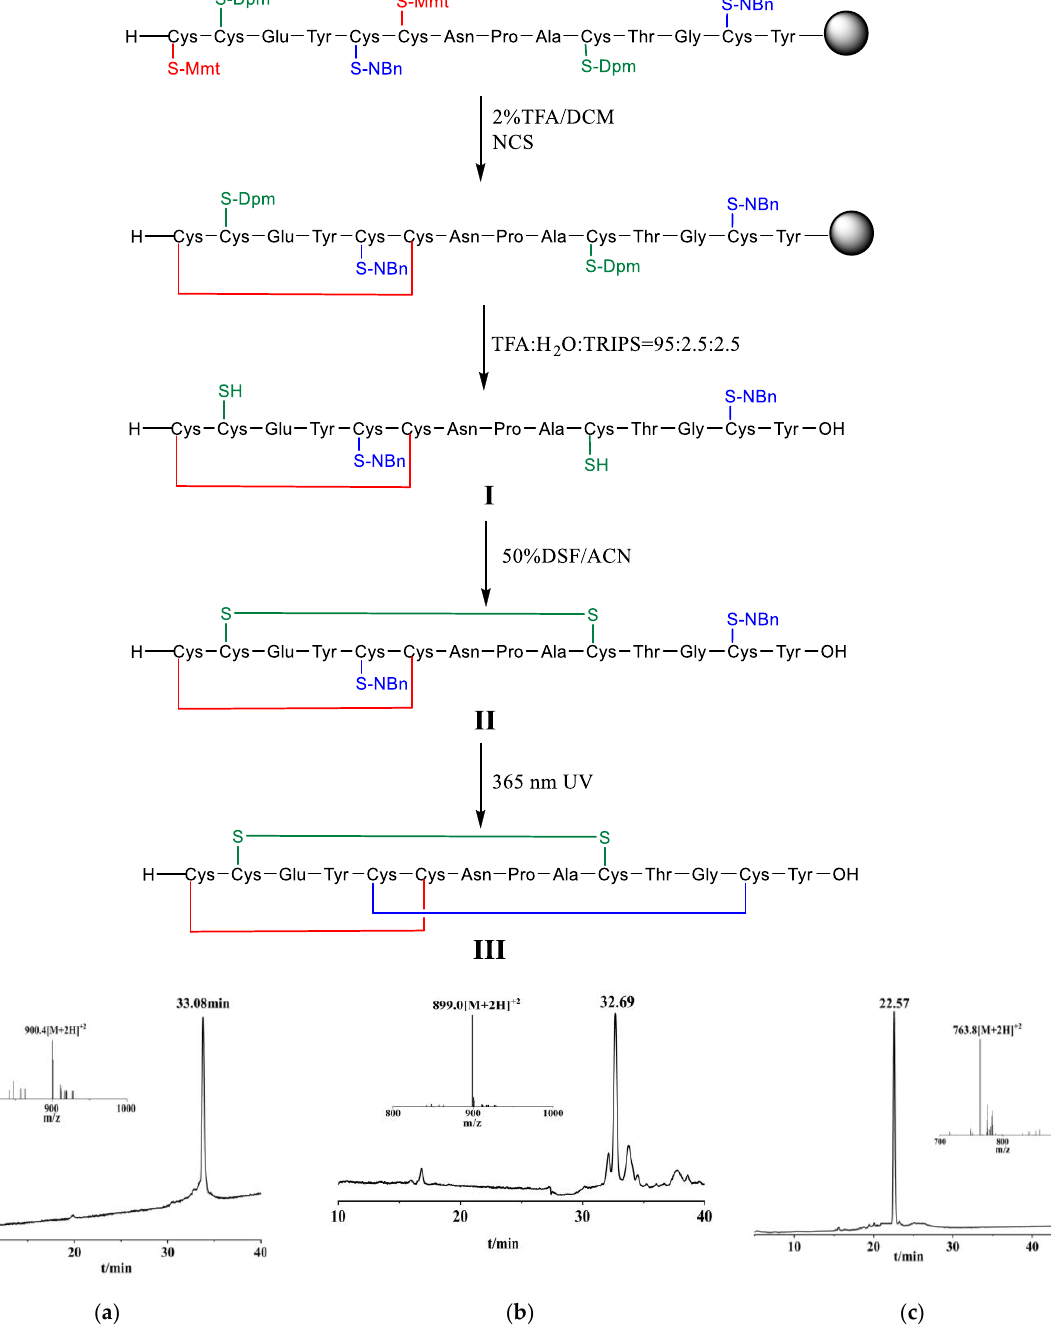
Figure 3. Linaclotide synthesis. ( a ) The main peak corresponds to Linaclotide with a single disulfide bond (I)with the observed mass 900.40 Da, calcd. 900.74 Da [M + 2H] 2+ . ( b ) The main peak corresponds to Linaclotide with two disulfide bonds (II )with the observed mass 899.07 Da [M+2H] 2+ , calcd. 899.73 Da. ( c ) The main peak corresponds to Linaclotide (III) with the three disulfide bonds with the observed mass 763.9 Da [M + 2H] 2+ , calcd. 763.70 Da. Dpm: diphenylmethyl, Mmt: 4-methoxytrityl, NBn: 2-nitrobenzyl, NCS: N -chlorosuccinimide, TFA: trifluoroacetic acid, TRIPS: triisopropylsilane, DCM: dichloromethane, DSF: disulfiram, ACN: acetonitrile.